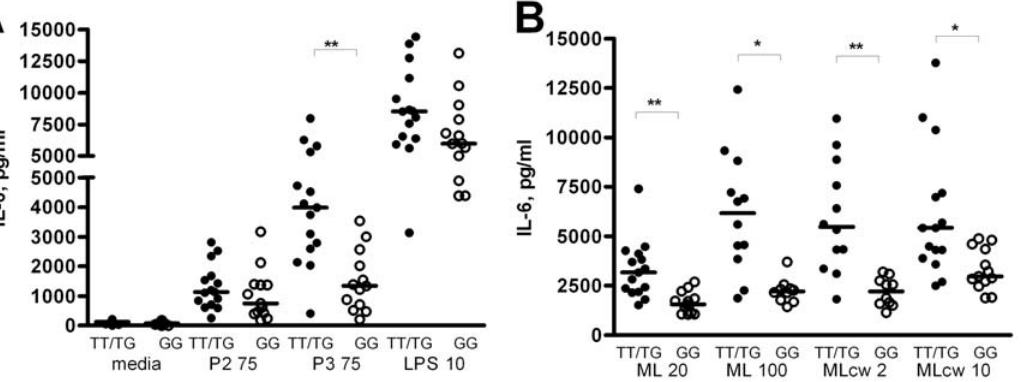
Figure 2. IL-6 production by human primary cells following stimulation with M. leprae. Peripheral blood mononuclear cells were stimulated for 18 hours and supernatants were assayed for cytokine production by ELISA. PBMCs were derived from whole blood taken from 15 individuals with the genotype 1805TTor 1805TG (TT/TG: dark circles) and 13 individuals with the 1805GG genotypes (GG: open circles). (A): PBMCs stimulated in triplicate with media, PAM2 at 75 ng/ml (P2 75), PAM3 at 75 ng/ml (P3 75), or LPS at 10 ng/ml (LPS 10). (B): PBMCs stimulated in triplicate with whole irradiated ML at 20 or 100 m g/ml (ML20 or ML100) or MLcw at 2 or 10 m g/ml (MLcw 2 or MLcw10). The mean level and standard error of the mean are depicted and were derived from averaging the responses of individuals stimulated in triplicate. The median level is depicted by a bar. *P # 0.01, **P # 0.001 by Mann–Whitney U-test.